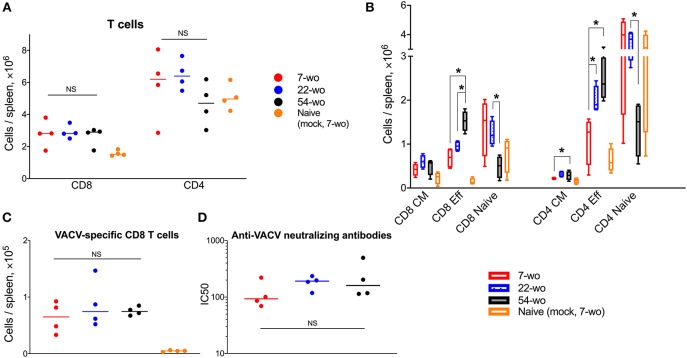
Vaccination with VACV induces a robust adaptive immune response in mice of different ages. Spleens and serum samples were obtained from vaccinated and naïve (mock-vaccinated) mice of different ages at 29 d post i.d. injection (n = 4-5 animals per group). (A) The absolute numbers of total splenic CD8 and CD4 T cells, and (B) their subpopulations are shown. Naive, central memory (CM), and effector (Eff). (C) Shows VACV-specific CD8 T cells. P-values were determined by the Mann-Whitney test, *p < 0.05. NS, non-significant. (D) Neutralizing antibody responses determined by plaque-reduction neutralization test. IC50, half maximal inhibitory concentration; NS, non-significant by Mann-Whitney test. All experiments were performed twice and representative data from one experiment are shown.